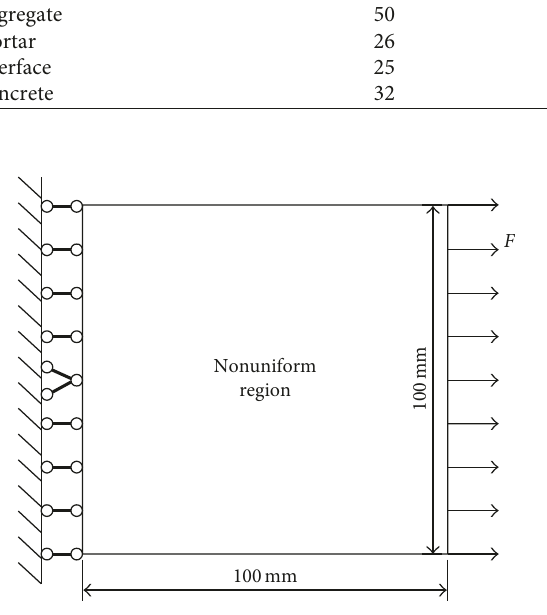
Figure 9: Uniaxial tensile specimen calculation diagram.